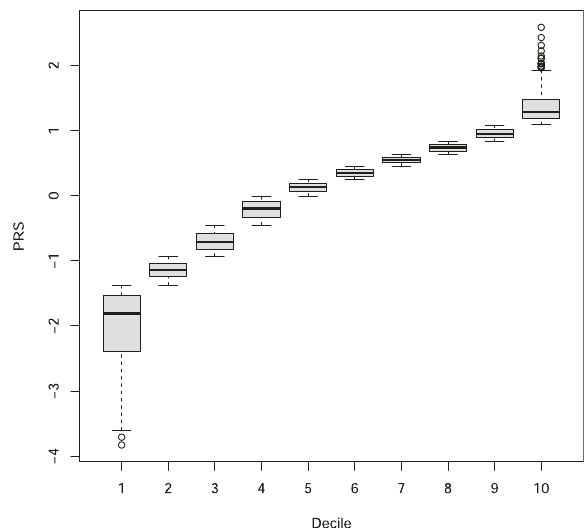
Fig. 1 Distributions of PRS gene in each decile in AA. Box-plots of each PRS gene decile.